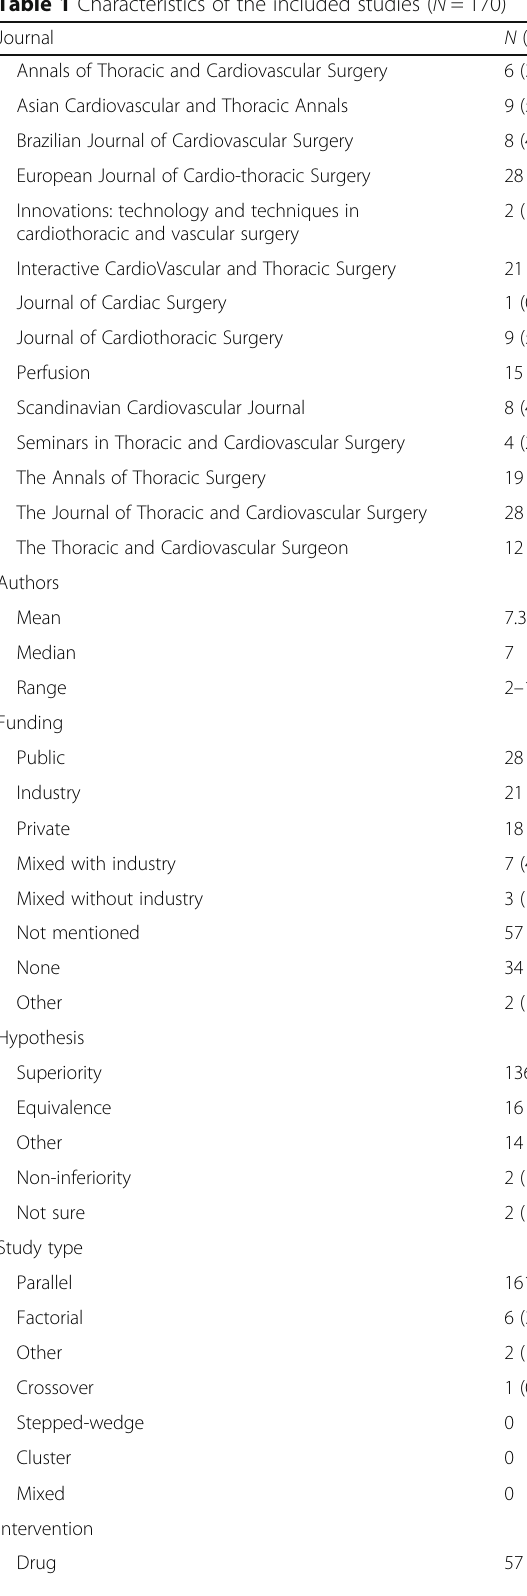
Table 1 Characteristics of the included studies ( N =